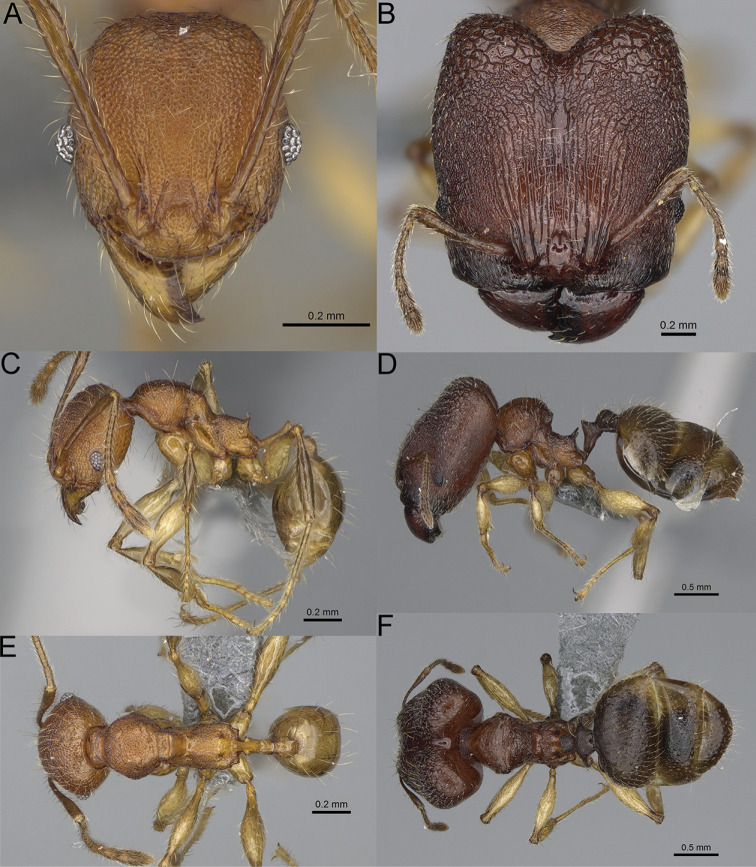
Pheidole
mantadia sp. nov., full-face view (A), profile (C), and dorsal view (E) of paratype minor worker (CASENT0923169) and full-face view (B), profile (D), and dorsal view (F) of holotype major worker (CASENT0297006).